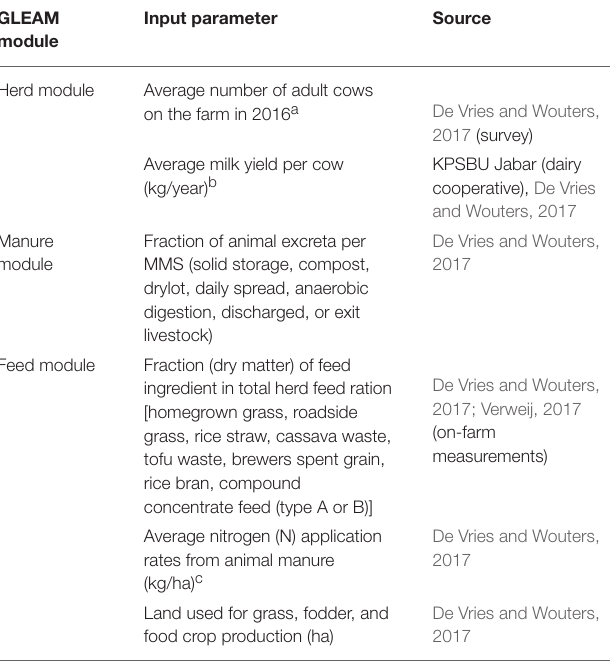
TABLE 1 | Farm-specific input data used in LCA